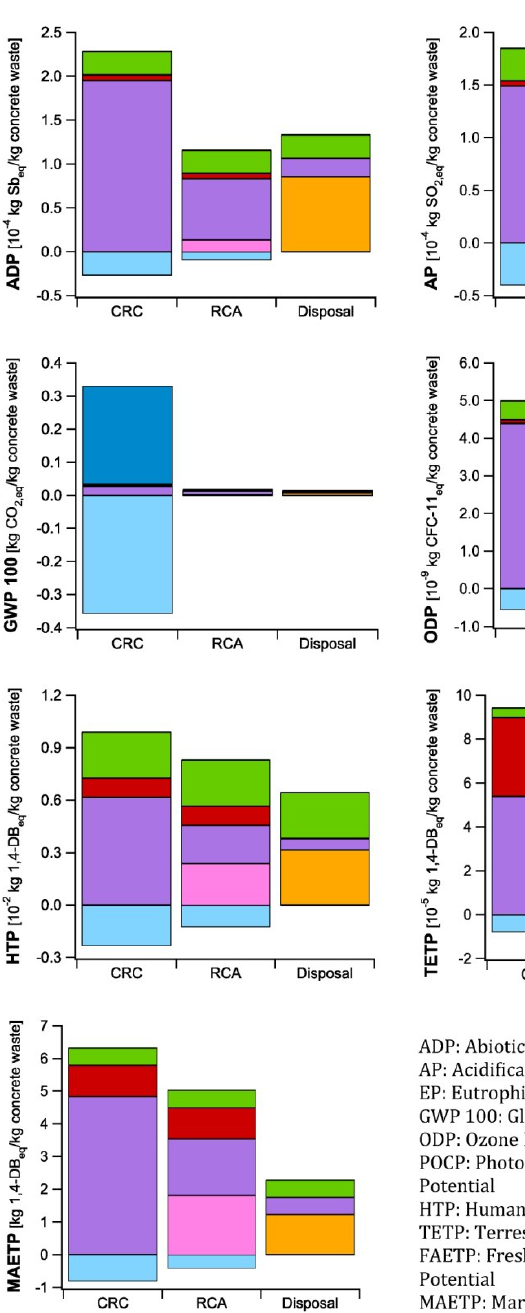
Figure 4. Life Cycle Impact Assessment of the different waste